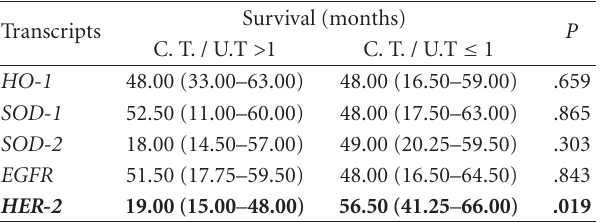
Figure 2: Kaplan-Meier plot of survival times in NSCLC patients classified by expression ratio levels of HER-2 transcript in cancerous versus una ff ected tissues (up to or higher than one). The dashed line represents subjects over-expressing HER-2 mRNA in the cancerous versus una ff ected tissues, whereas the continuous line indicates subjects with lower expression levels of HER-2 mRNA in cancerous versus una ff ected tissue samples. Crosses indicate censored subjects, represented by patients still alive at 1st April 2008. Table 3: Average survival times in subjects classified according to the expression levels of di ff erent transcript in cancerous (C.T.) versus una ff ected (U.T.) tissues. Medians and interquartile (25th– 75th) ranges of values are shown, as well as the results of the Mann- Whitney U test ( P )